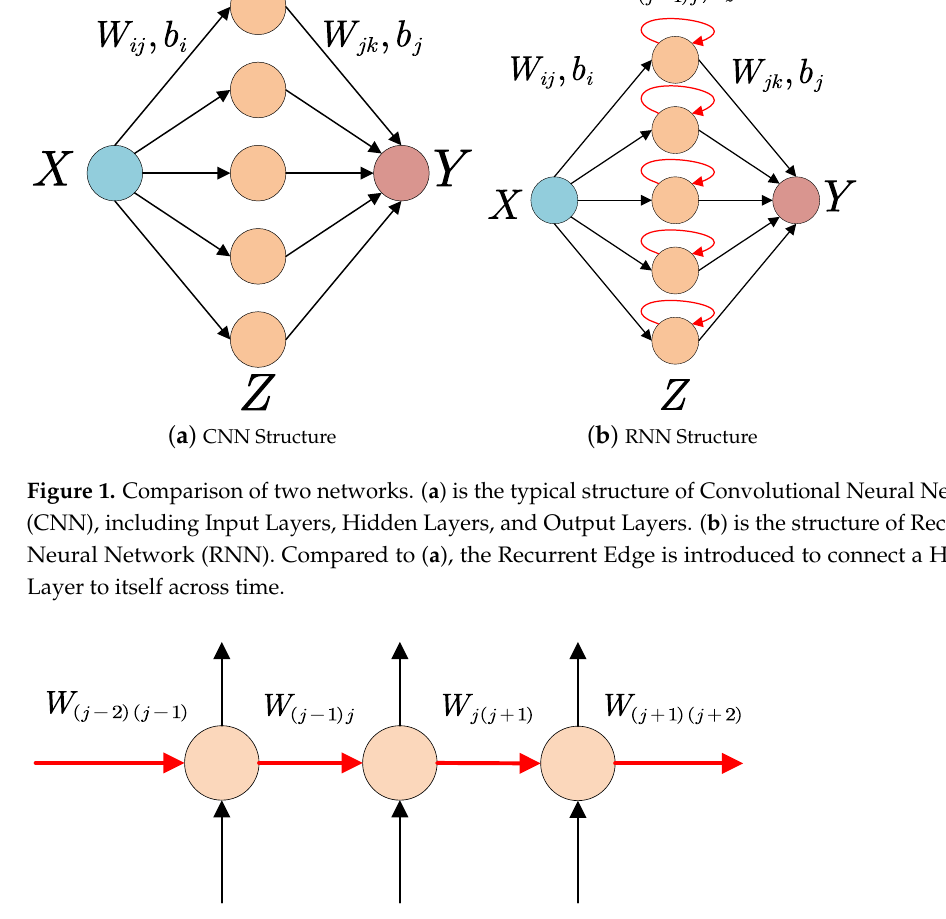
Figure 2. A Detailed demonstration of Recurrent edges. Results of last time are transmitted in the network and contribute to the values of next time by special